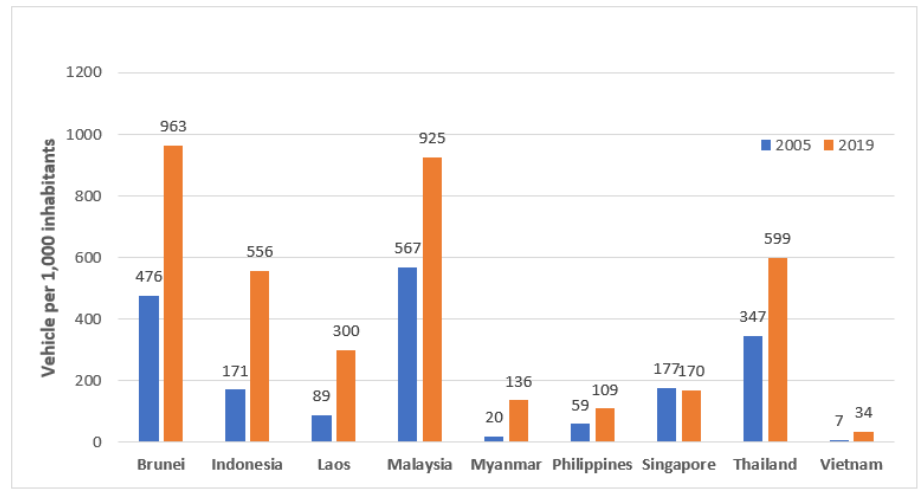
Figure 3. Registered vehicles per 1000 inhabitants in East Asia. Source: Compiled from [64].